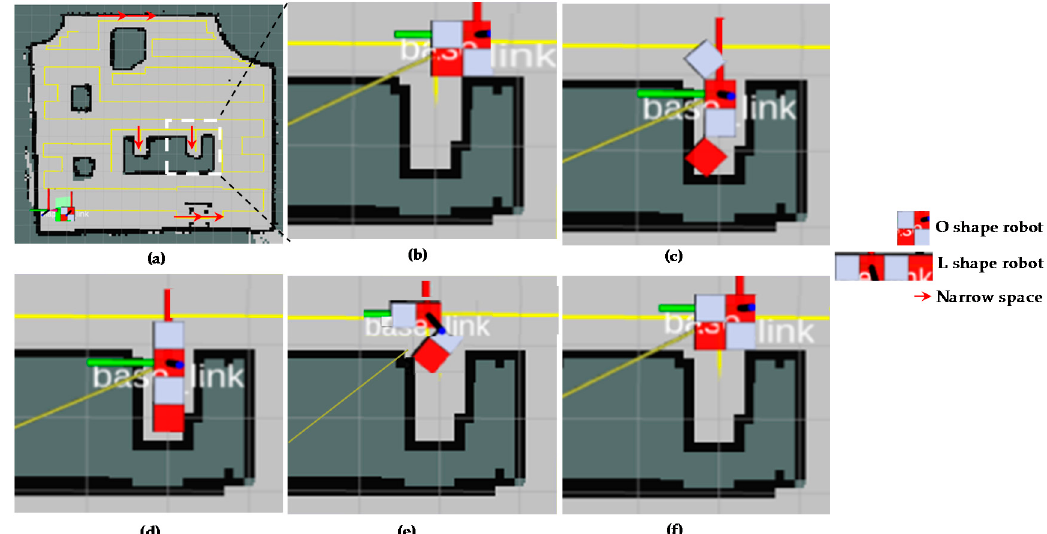
Figure 18. Morphology reconfigurations from O shape to horizontal I shape to navigate through the narrow spaces constraints on RVIZ. ( a ) Detected narrow spaces as red arrows, ( b ) the position before reconfiguring morphology, ( c ) starting morphology reconfiguration, ( d ) navigating with horizontal I shape, ( e ) Morphology reshapes to O after going out of narrow space, ( f ) keep navigating with O shape.